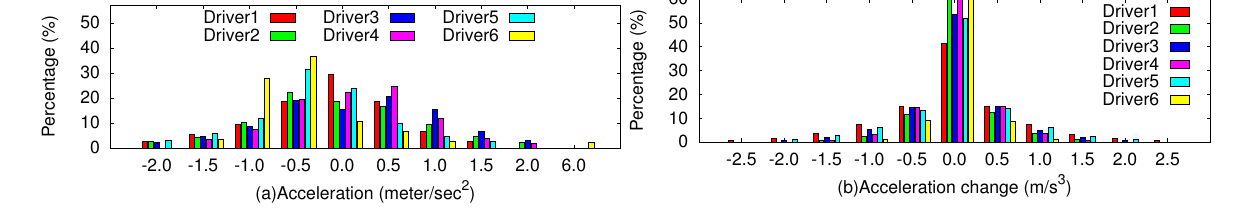
Figure 12. Acceleration (acc.) and Acc. change frequency histogram comparison of different drivers.